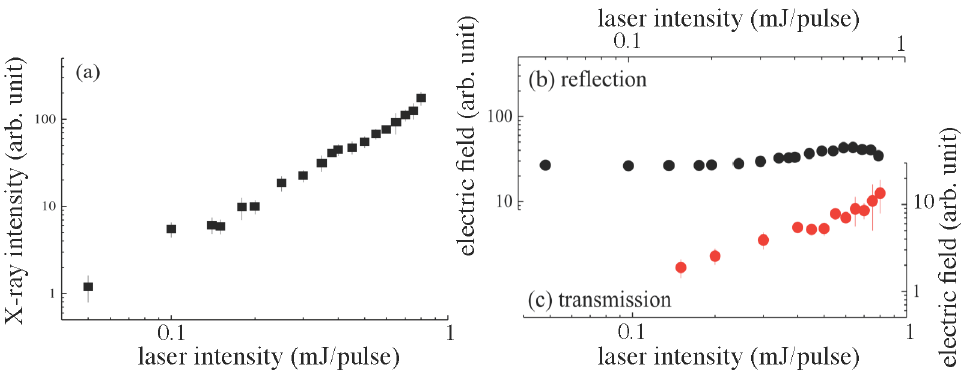
Figure 2. Laser intensity dependencies of ( a ) X-ray and THz wave intensities ( b ) in the reflection and ( c ) in the transmission. The laser polarization was horizontal to the solution flow, i.e., p-pol. During the measurements, the solution flow position along the Z -axis was finely optimized for the highest X-ray intensity at each laser